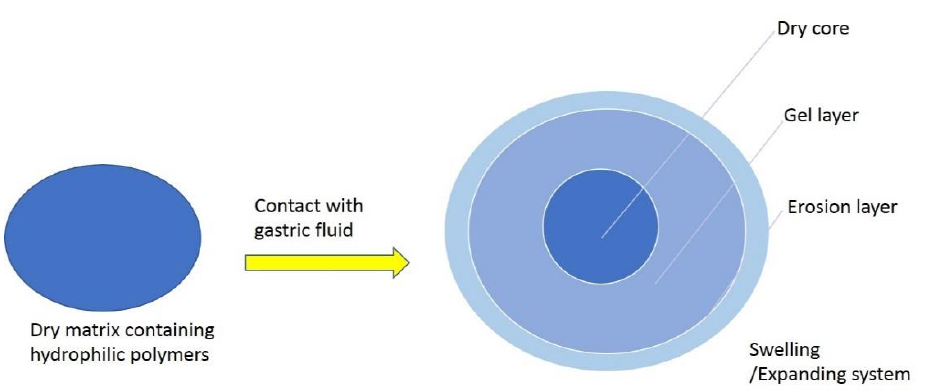
Fig. 2. Illustrative photo of a Swelling / Expanding